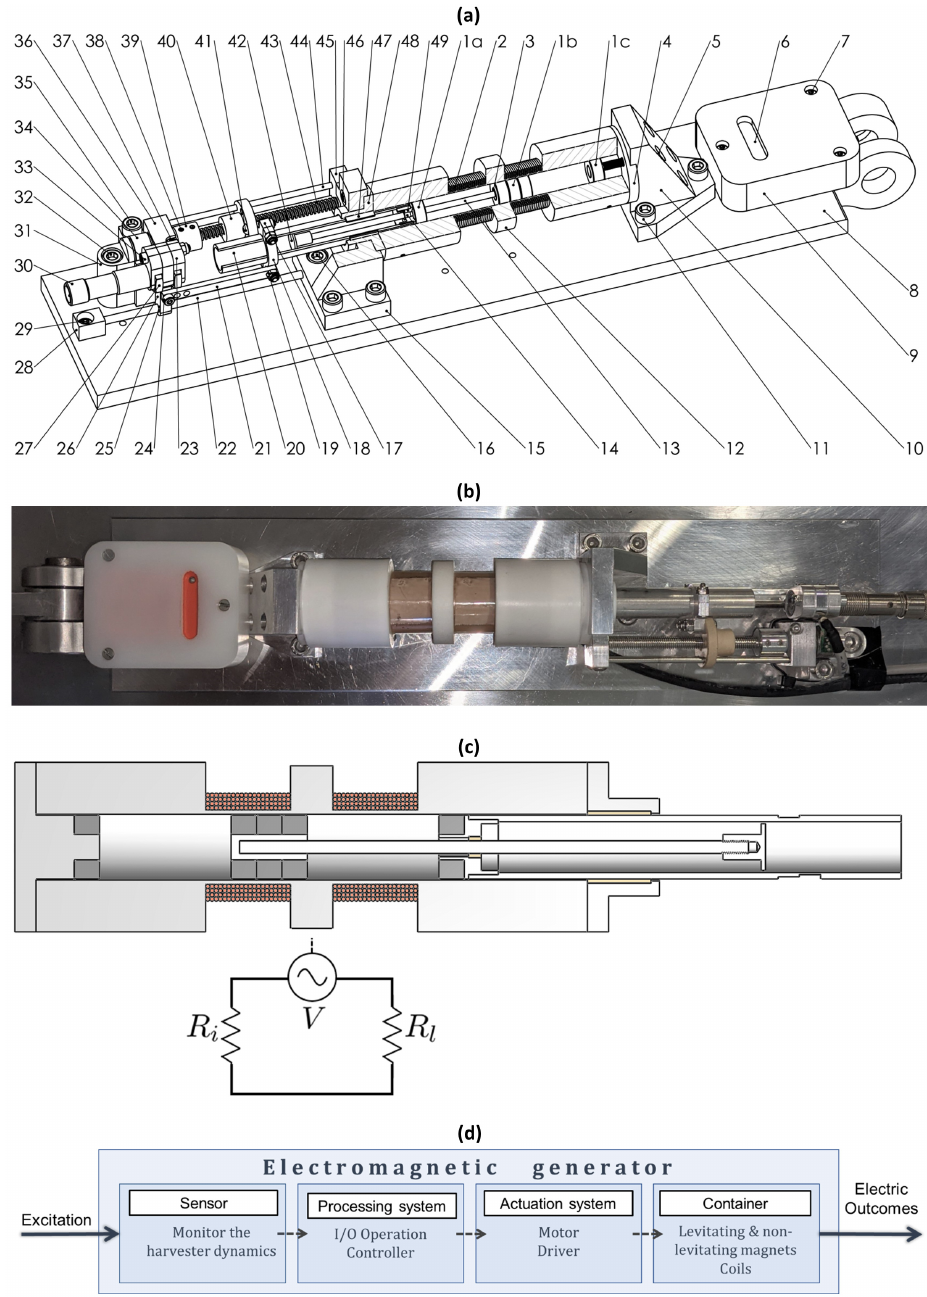
Figure 1. ( a ) Three-dimensional section view of the self-adaptive harvester; ( b ) platform to exper- imentally validate the concept of self-adaptive electromagnetic energy harvesting; ( c ) schematic representation of the electromagnetic harvester and electric circuit diagram; and ( d ) diagram rep- resenting a control approach only using data from the excitation dynamics. Legend: 1a–adaptive non-levitating magnet; 1b–levitating magnets; 1c–non-levitating magnet; 2–coil; 3–magnet–rod cou- pling; 4, 48–lid; 5, 7, 11, 16, 24, 29, 32, 33, 35, 37, 41, 46–screw; 6–accelerometer; 8–aluminium board; 9–accelerometer housing; 10, 15, 26, 28, 31, 36, 45–support; 12–container; 13–inertial guiding rod; 14, 25, 47–sleeve bearing; 17, 18–tube–nut fastener; 19–lock nut; 20–tube; 21–spacer; 22, 44–guiding shaft; 23–anti-vibration fastener; 27–sensor nut; 30–ultrasonic sensor; 34–stepper motor; 38–stud; 39–motor–spindle coupling; 40–sliding nut; 42–extremity of inertial mass; 43–trapezoidal spindle screw; 49–tube–magnet